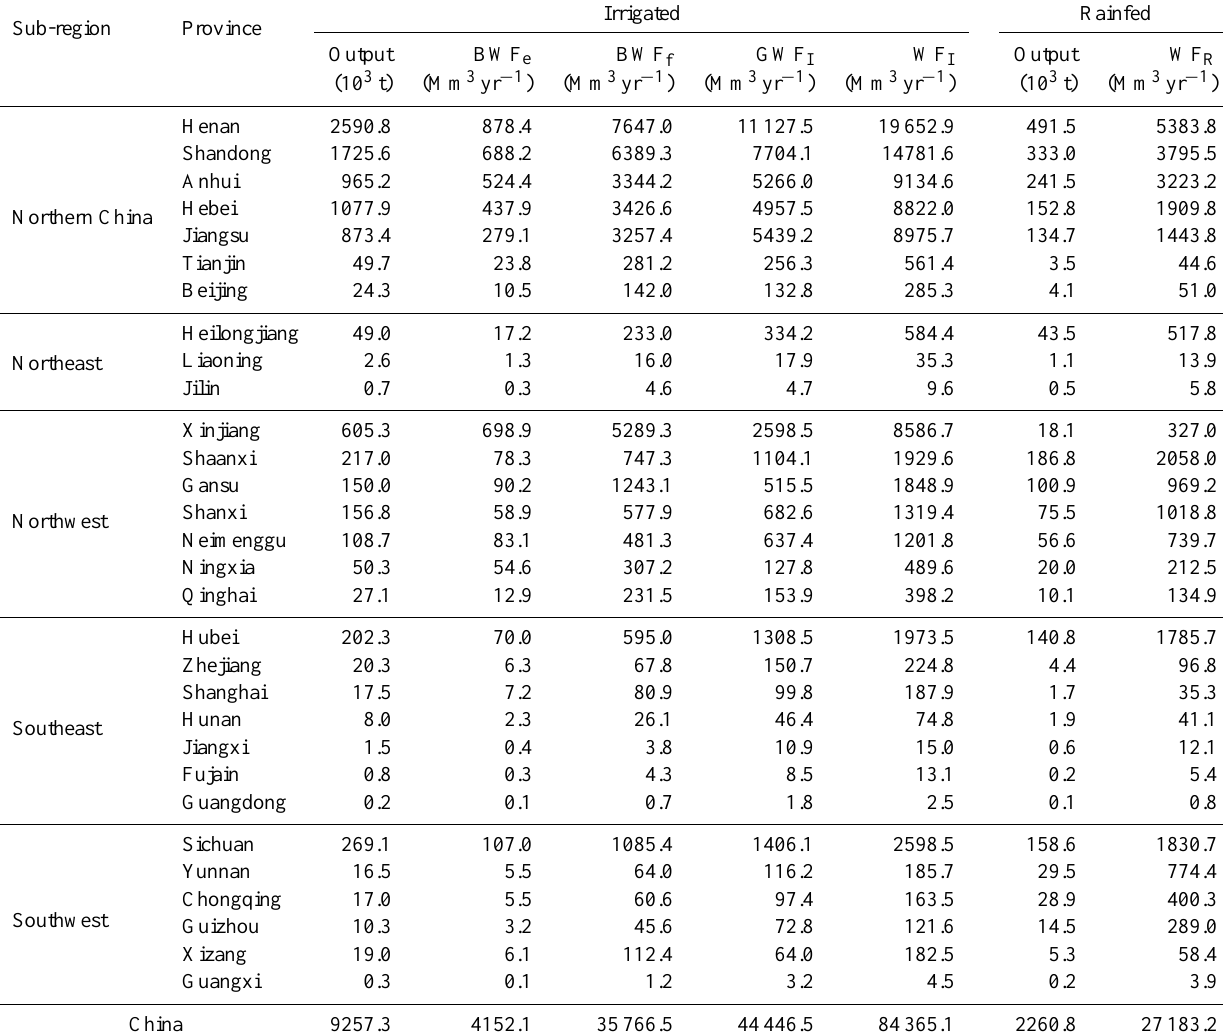
Table 2. Provincial water footprint of wheat production in irrigated and rainfed farmland.